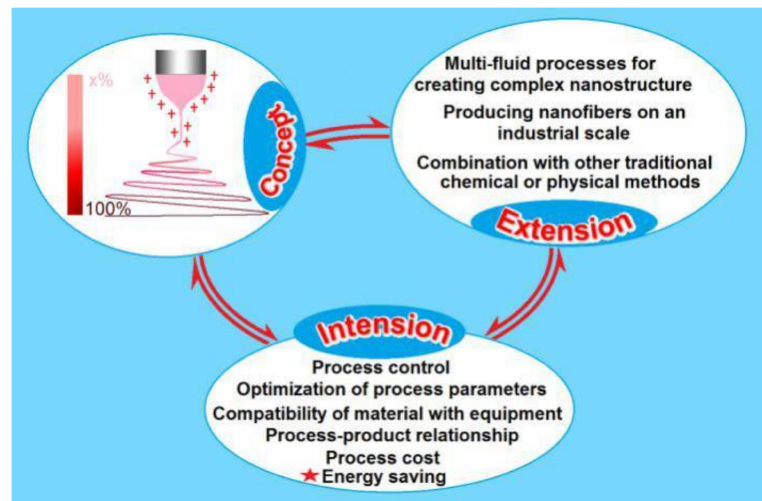
Figure 1. Concept, development, and applications of